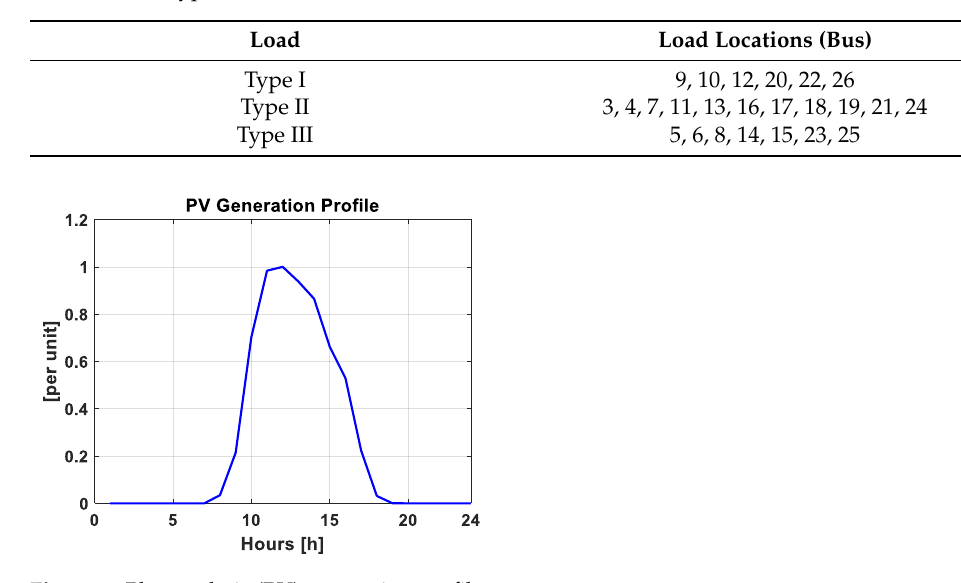
Figure 7. Load profile for each load type: ( a ) type I — residential load; ( b ) type II — public and service; ( c ) type III — industrial load . Table 1. Load type and locations. Table 1. Load type and locations.